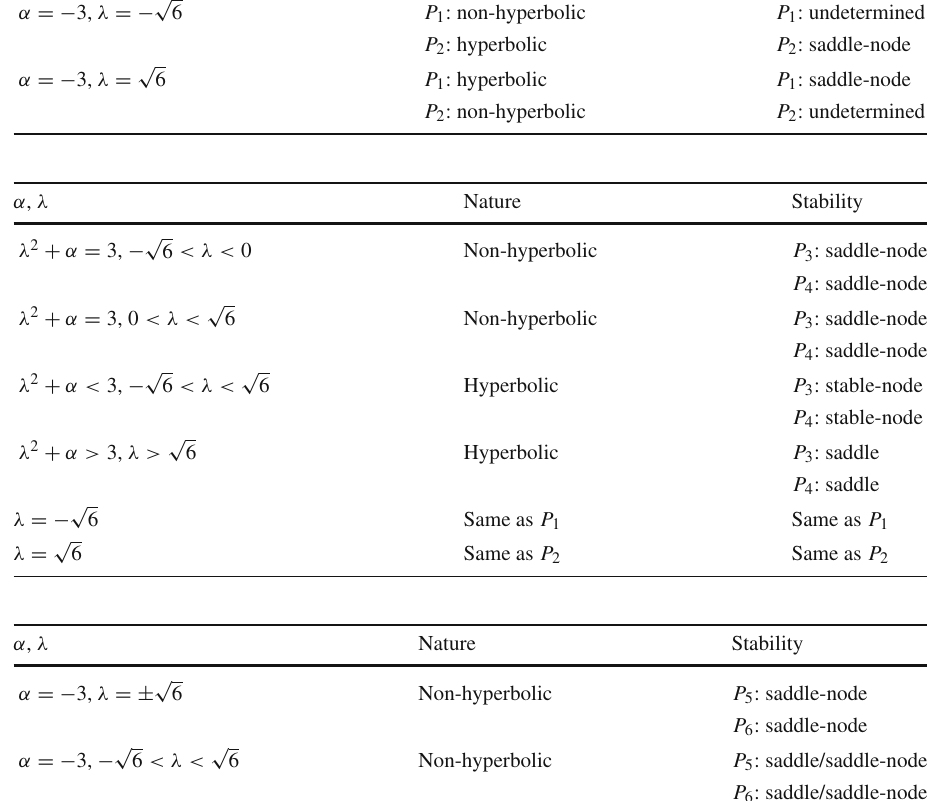
Table 7 Stability of P 3 and P 4 according to range of parameters